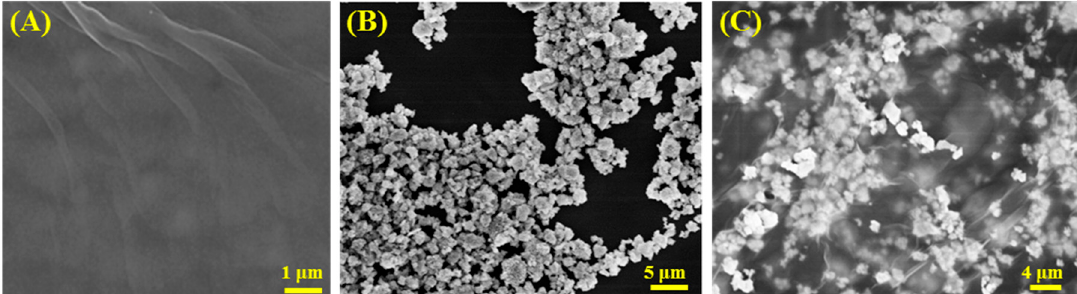
Figure 1. Electron microscopy images of the ( A ) pure graphene oxide (GO), ( B ) pure Ta 2 O 5 nanoparticles, and ( C ) Ta 2 O 5 -GO composite nanoparticles.